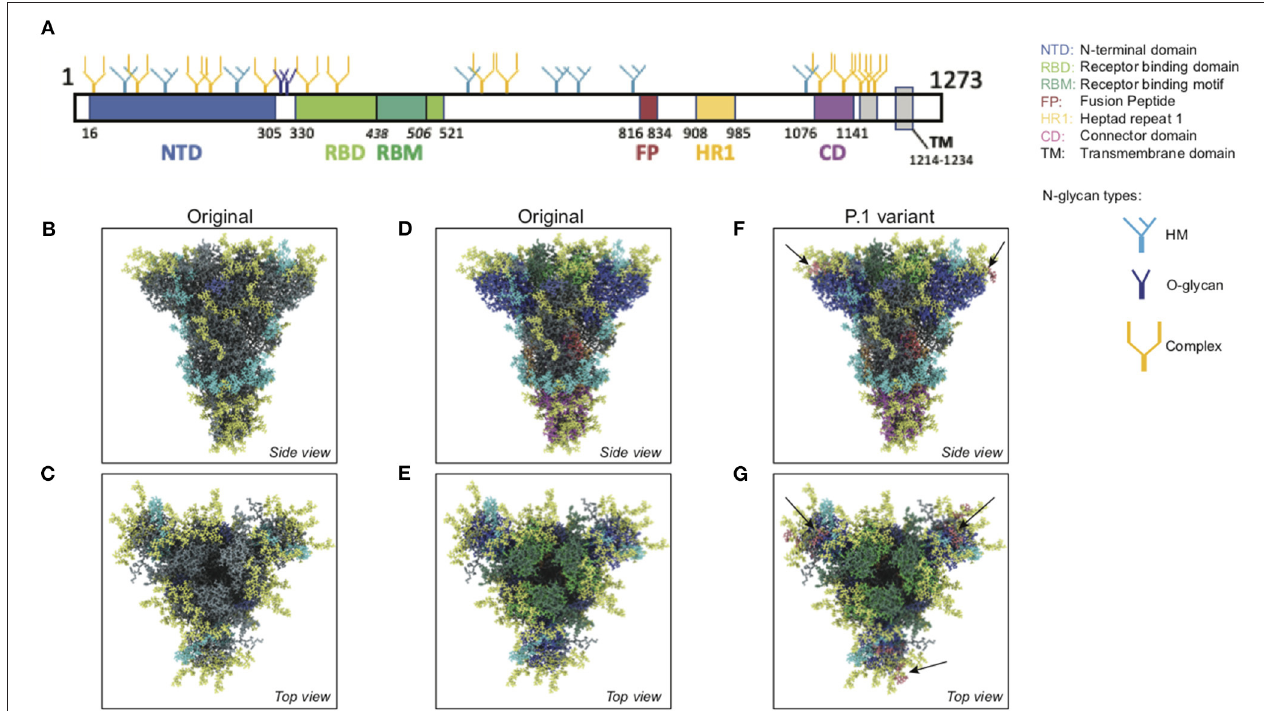
FIGURE 11 | Atomistic reconstruction of the glycosylated SARS-CoV-2 spike. ( A) Schematic of the primary structure of the SARS-CoV-2S protein with the different types of glycan-trees positioned on the different domains as detailed on the right legend. (B,C) Side and top view of the SARS-CoV-2 glycosylated spike in closed conformation. The three types of glycan trees are colored according to the legend on the right. (D,E) Side and top view of the SARS-CoV-2 glycosylated spike in closed conformation such as in (B,C) , but with the different domains colored according to the legend used in (A) . (F,G) Side and top view of the modeled glycosylated spike from the Brazilian P.1 variant in closed conformation. The potential additional glycan-tree in position N20 is colored in red and indicated with arrows. Representations of the spike in (B–G) were generated with BioExplorer; positions and sources of the glycans are detailed in